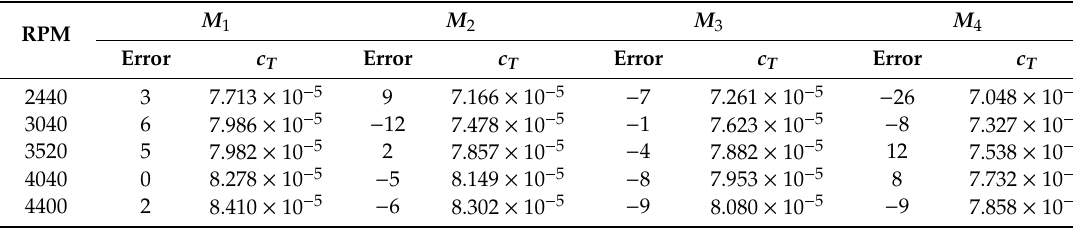
Figure 15. c T values of each motor by experiment. Figure 15. 𝑐 𝑇 values of each motor by experiment. Table 5. Comparing c T of each motor in similar range of